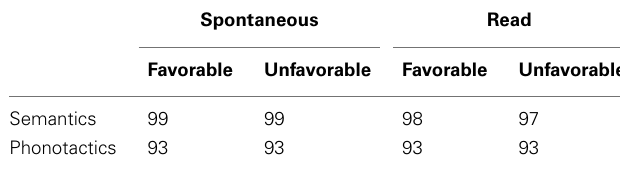
Table 3 | Overview of the 136 cross-modal identity priming trials. Priming: